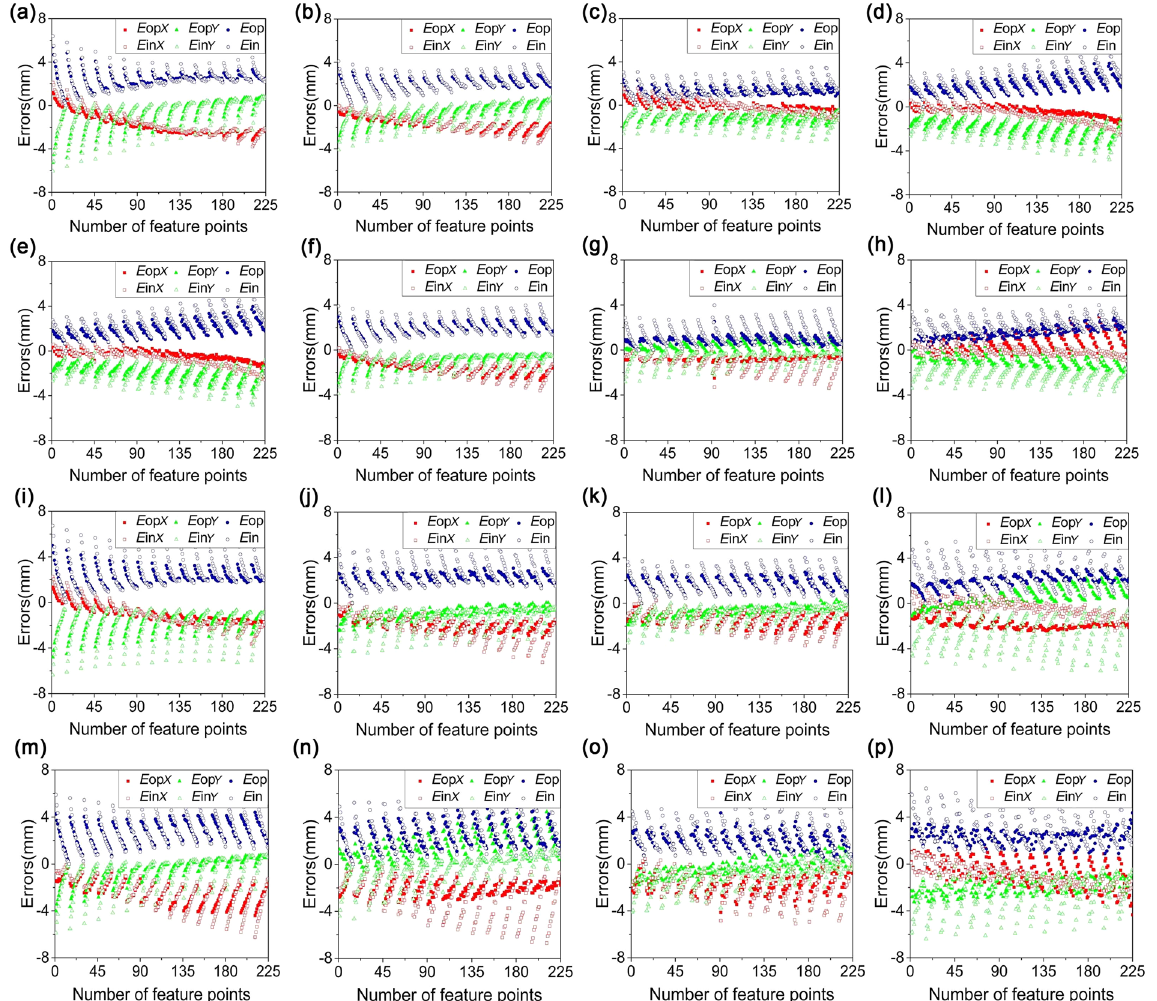
Figure 6. Recovery errors of the active solutions of the homographies in the verification experiments. The subscript “in” indicates the initialization method. The subscript “op” indicates the optimization method. The subscripts “ X ” and “ Y ” indicate the errors along the X direction or Y direction. E in and E op are the combined errors of the initialization method and the optimization method. MD indicates the measurement distance, mm. RA indicates the relative angle, °. ( a ) MD = 500, RA = 4. ( b ) MD = 600, RA = 4. ( c ) MD = 700, RA = 4. ( d ) MD = 800, RA = 4. ( e ) MD = 500, RA = 8. ( f ) MD = 600, RA = 8. ( g ) MD = 700, RA = 8. ( h ) MD = 800, RA = 8. ( i ) MD = 500, RA = 12. ( j ) MD = 600, RA = 12. ( k ) MD = 700, RA = 12. ( l ) MD = 800, RA = 12. ( m ) MD = 500, RA = 16. ( n ) MD = 600, RA = 16. ( o ) MD = 700, RA = 16. ( p ) MD = 800, RA =